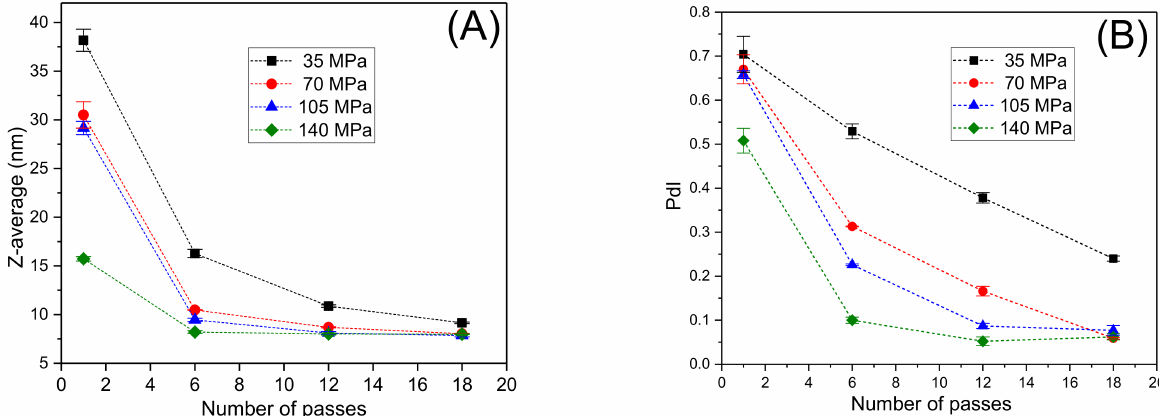
Figure 1. ( A ) Droplet mean diameters and ( B ) polydispersity index values for emulsions aged for 24 h as a function of the number of passes and homogenization pressure. Vertical bars indicate standard deviation of the mean (three